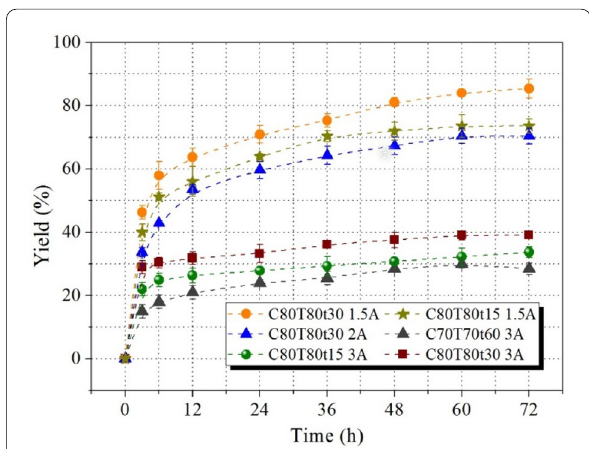
Fig. 4 Enzymatic saccharification of substrates with different FA